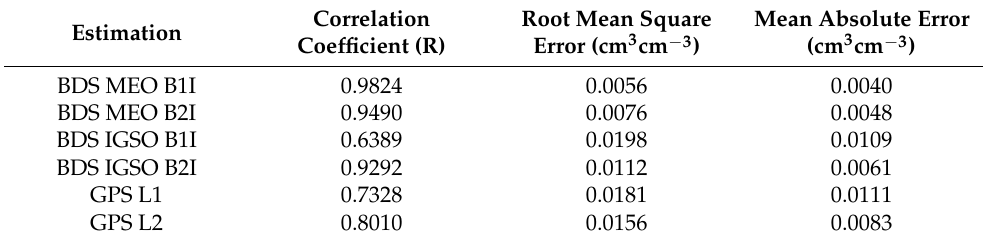
Figure 13. Errors between estimations and soil moisture. Table 3. Soil moisture estimation precision